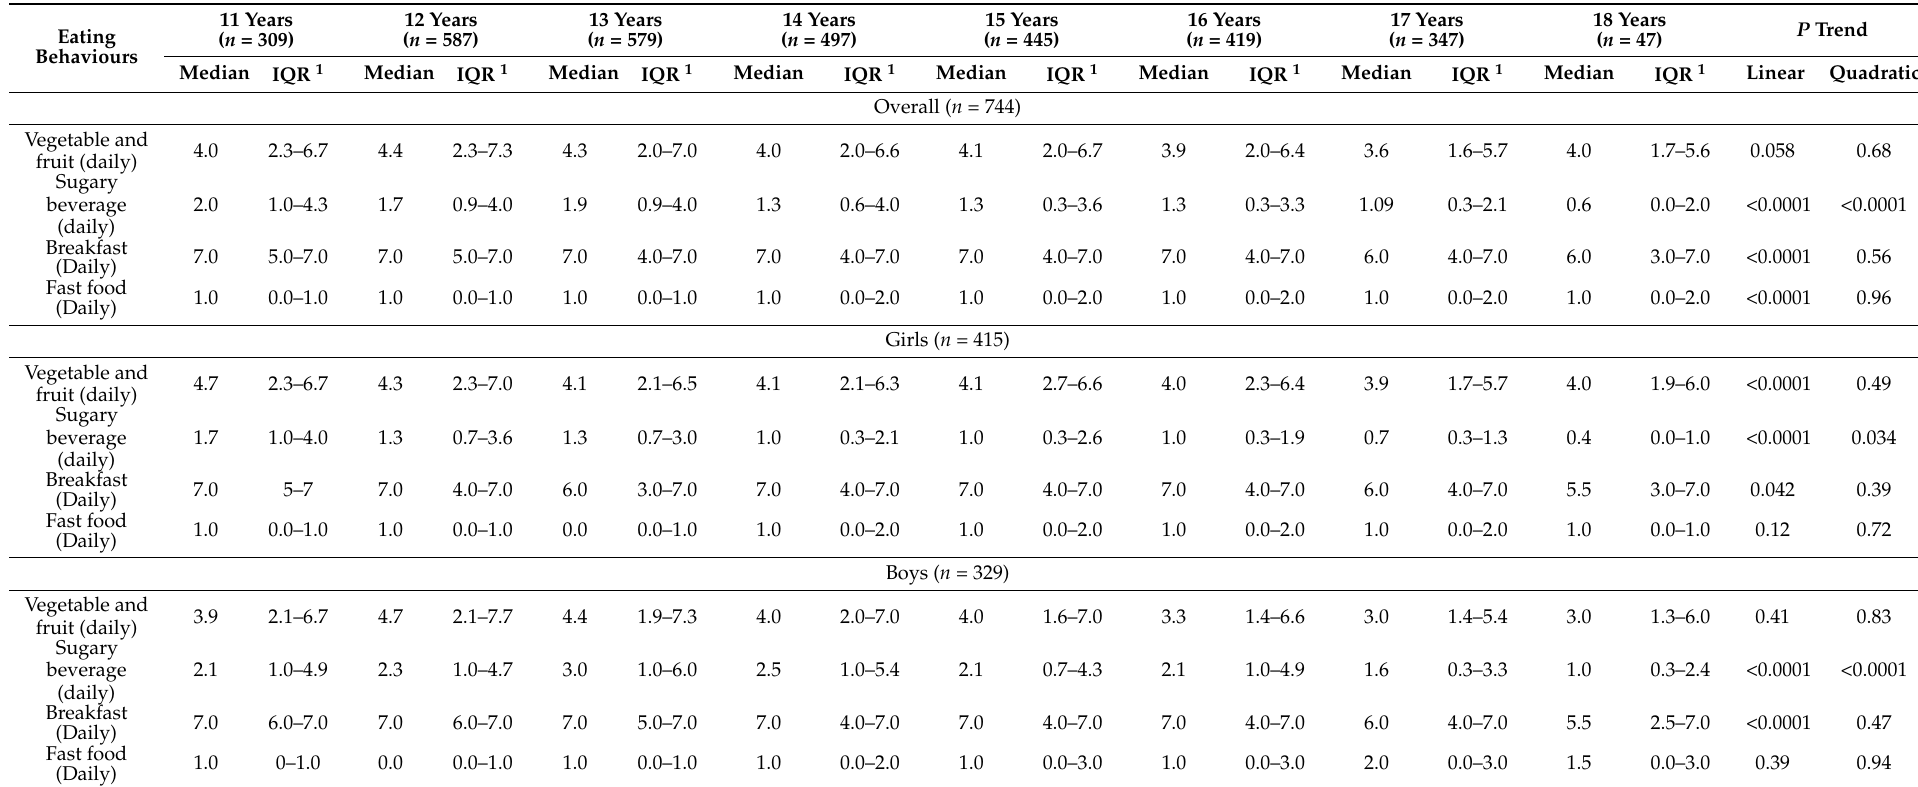
Table 1. Median frequencies of eating behaviours from childhood to